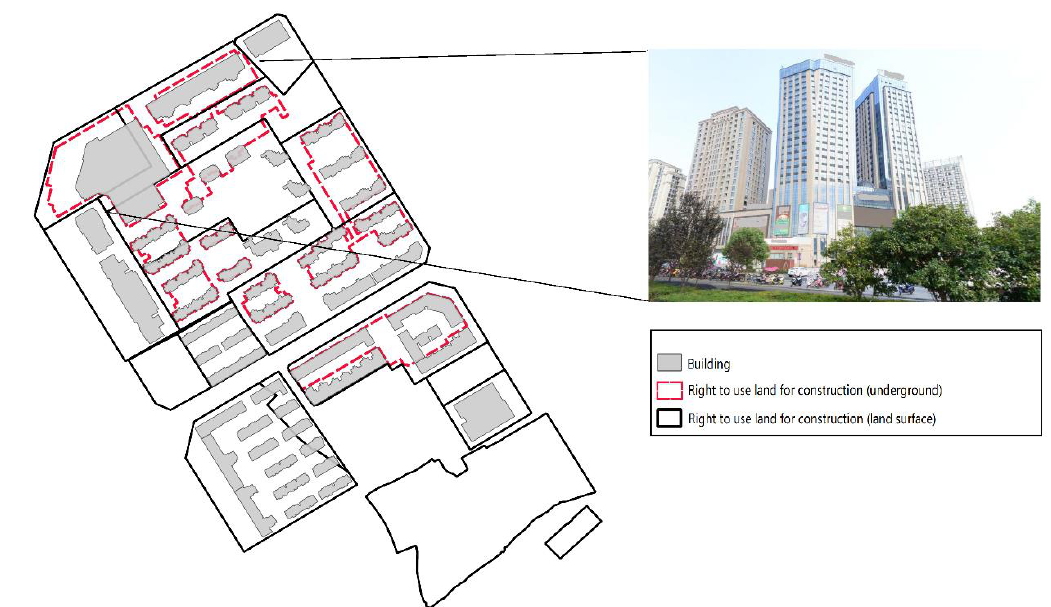
Figure 7. An urban cadastre scenario in China with overlapping real estate rights. The right to use the land for construction is set either on the land or underground.